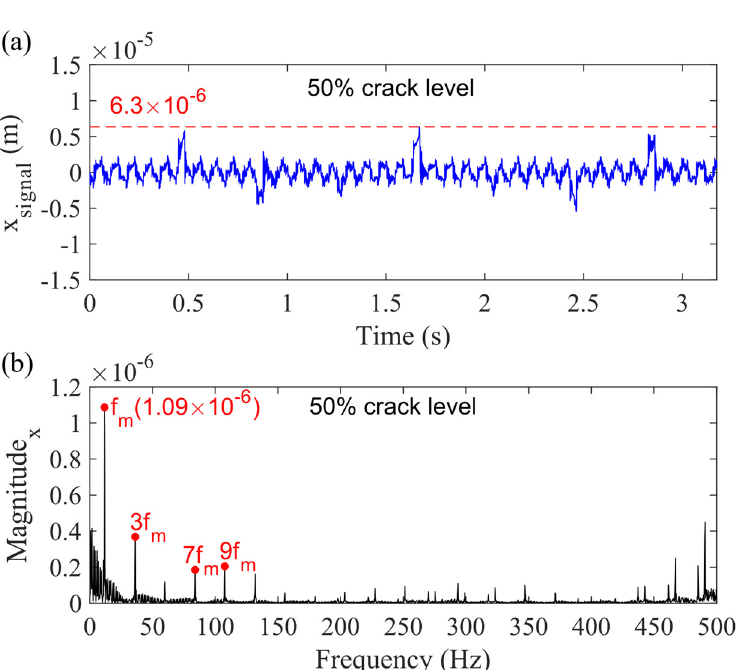
Figure 10. Sum vibration response for 50% sun gear crack level in x g -direction: ( a ) time domain waveform and ( b ) frequency spectrum.